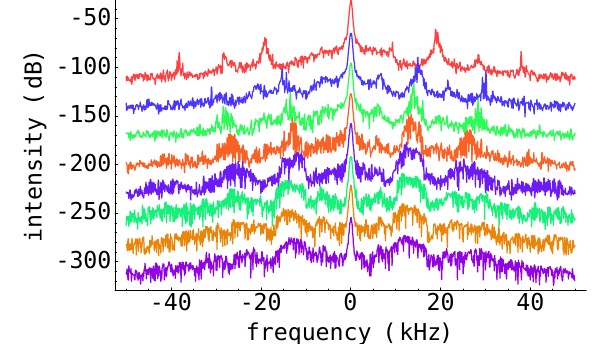
FIG. 4. The intensity as a function of time of the synchrotron sideband of the second to the lowest trace of Fig. 3 centered at about 12 kHz offset taken with a spectrum analyzer at 3 kHz resolution bandwidth. The discontinuity near the center of the horizontal axis is an artifact from the instrument. Machine pa- rameters are given in Table